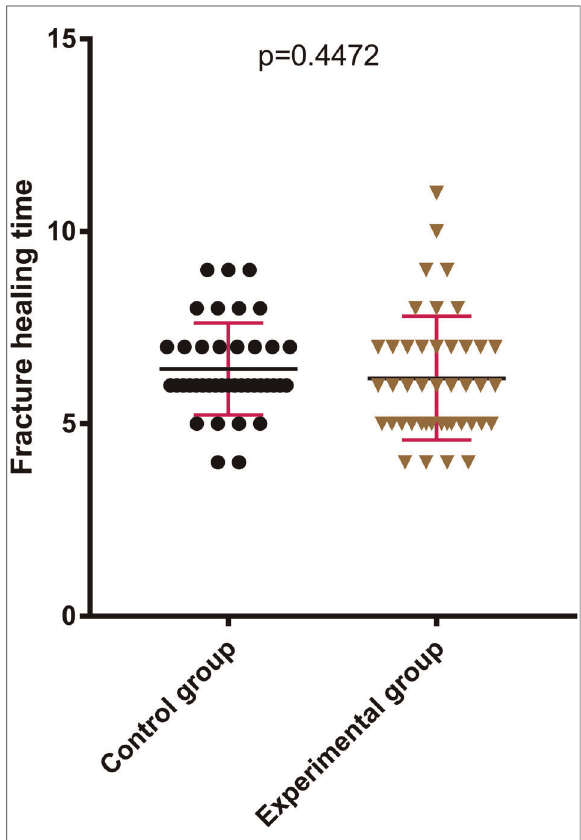
FIGURE 6 There was no signi fi cant difference in fracture healing time between the two